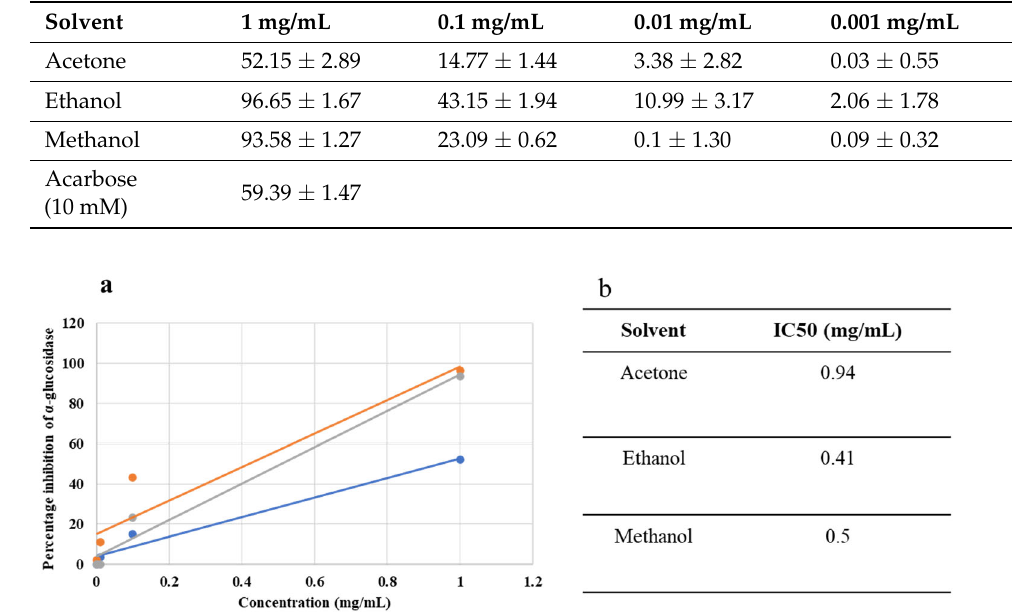
Figure 2. Dose–response curve ( a ) and IC 50 values ( b ) of acetone-, ethanol-, and methanol-based extracts.